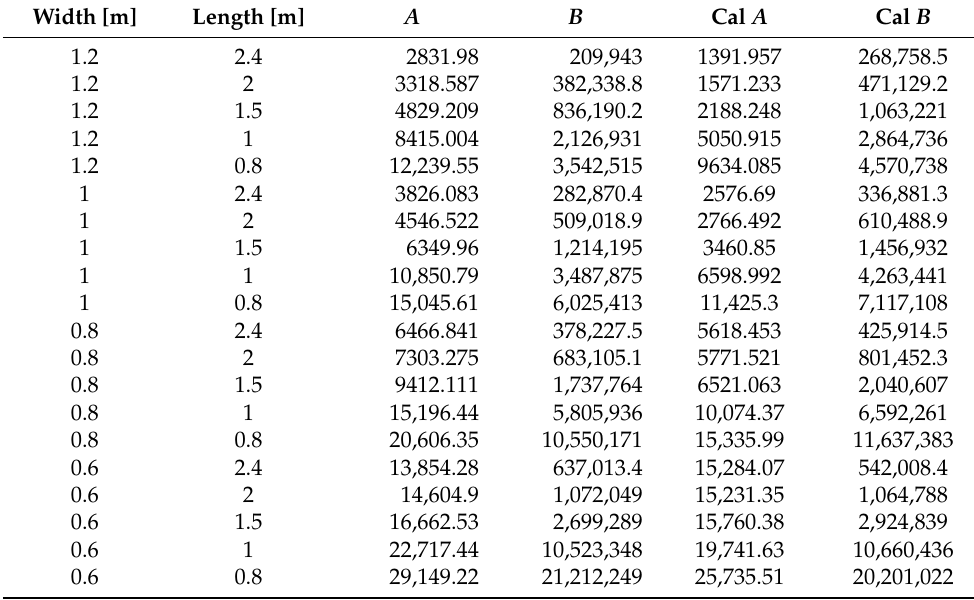
Table A10. The 8 mm plate FEA A , B and theory calculated A , B